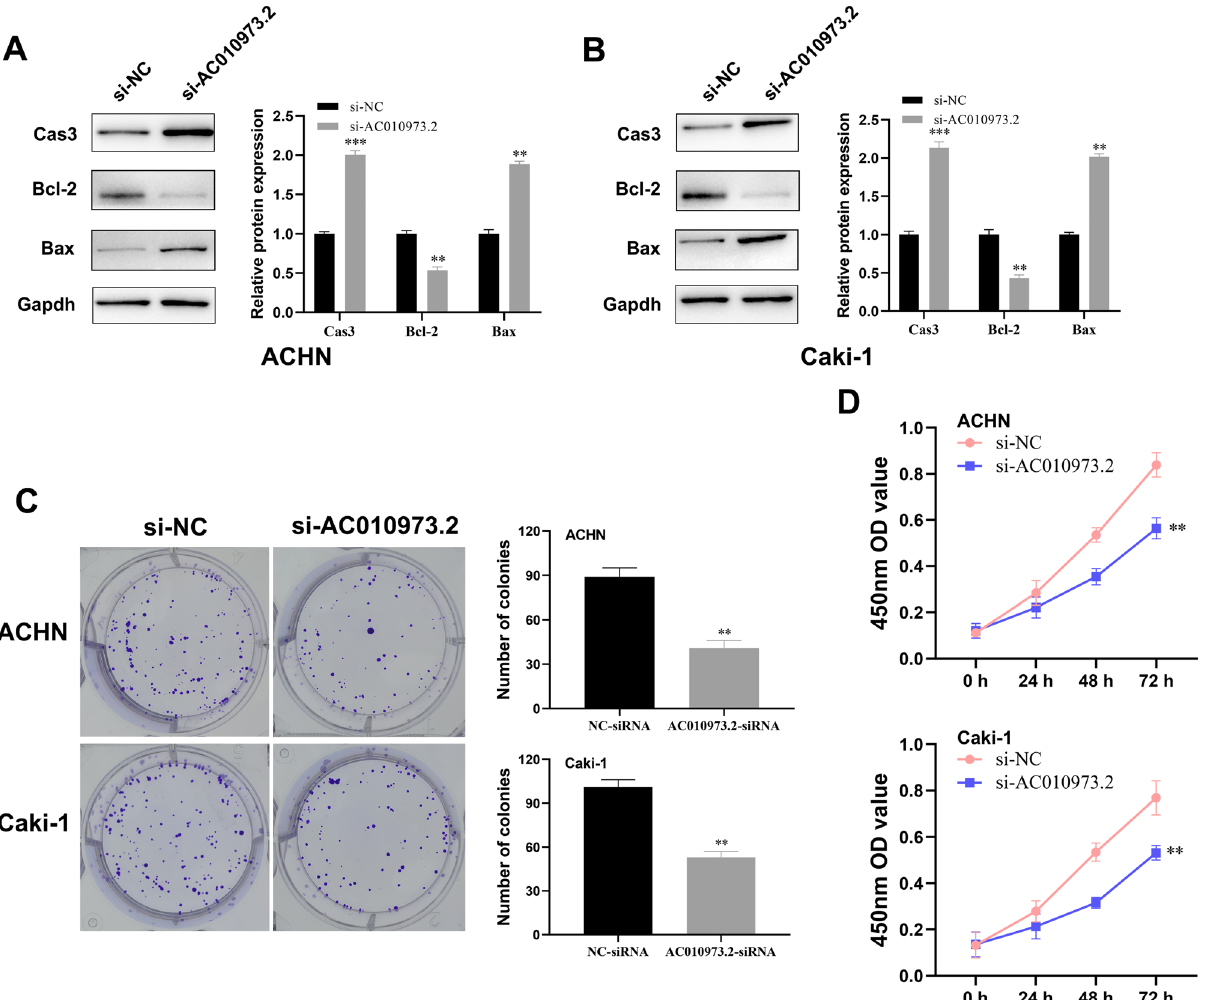
cell lines through Western Blot; the blots were cut prior to hybridization with antibodies for saving antibodies. ( C ) Colony formation assay of ACHN and Caki-1 after the knockdown of AC010973.2. ( D ) CCK8 assay of ACHN and Caki-1 after the knockdown of